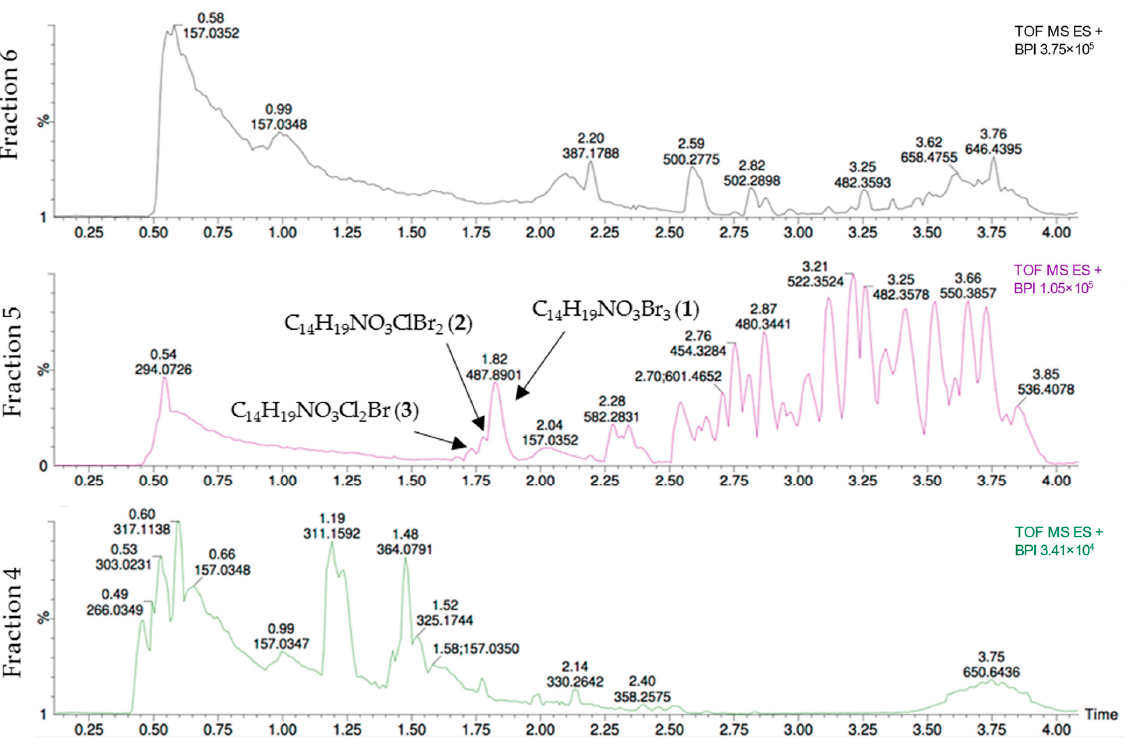
Figure 2. UHPLC-HR-MS chromatograms of the cytotoxic flash fraction five, as well as the non- cytotoxic fractions four and six of the organic extract of Pteraster militaris . Three halogenated sec- ondary metabolites were exclusively present in flash fraction five, which suggests their involvement in the activity seen towards the human melanoma cell line A2058.